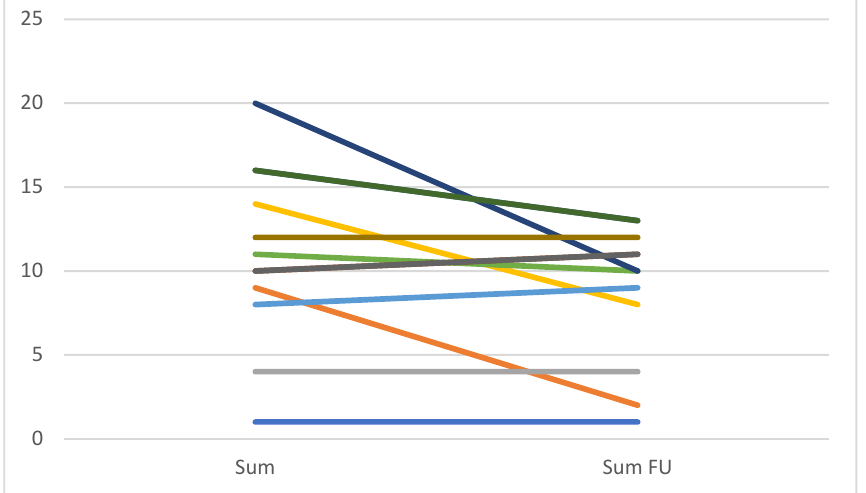
Figure 2. The NTM-CT score changes before and after successful NTM-PD treatment.